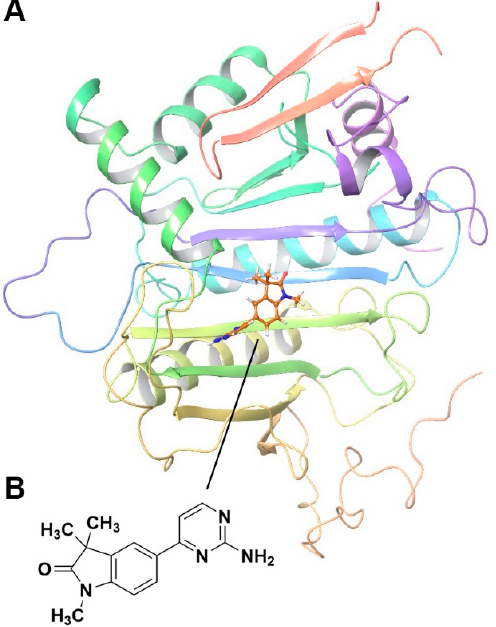
Figure 2. Cont Figure 2. Cont. Figure 2. Cont.